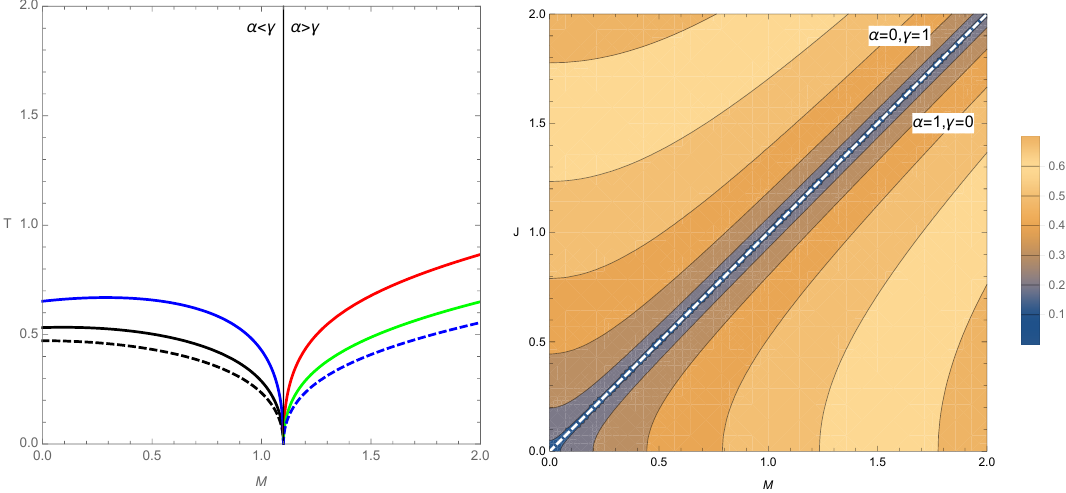
Figure 1 . Left: the two di(cid:11)erent sectors of the ( T; M ) parameter space are divided by the vertical black line, which corresponds to the extremal case ‘M = J . The area on the left ( (cid:11) < (cid:13) ) admits the exotic solution (cid:13) = 1 ; (cid:11) = 0 (black dashed line) for J = 1 : 1 whereas the area on the right ( (cid:11) > (cid:13) ) admits the standard BTZ solution (cid:13) = 0 ; (cid:11) = 1 (blue dashed line) for J = 1 : 1. The black/blue solid lines at the left are the respective cases ( (cid:11) = 0 : 2 ; (cid:13) = 0 : 6) and ( (cid:11) = 0 : 4 ; (cid:13) = 0 : 6), whereas the red and green solid lines respectively correspond to ( (cid:11) = 0 : 6 ; (cid:13) = 0 : 4) and ( (cid:11) = 0 : 8 ; (cid:13) = 0 : 2). Right: contour plot of the temperature as function of J and M for the two sectors: the exotic and the standard